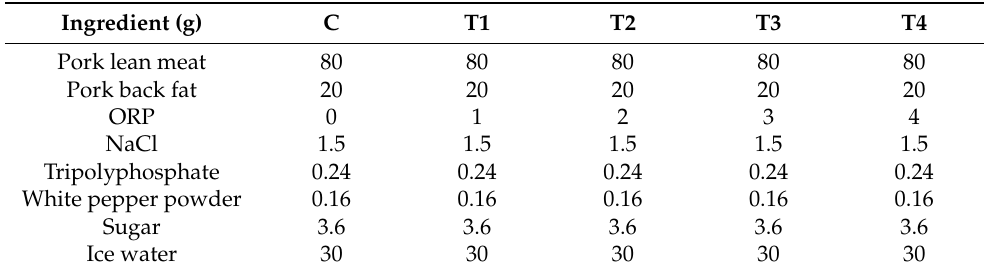
Table 1. Formulations of lower-fat meat batters prepared with Oudemansiella raphanipies powder at various